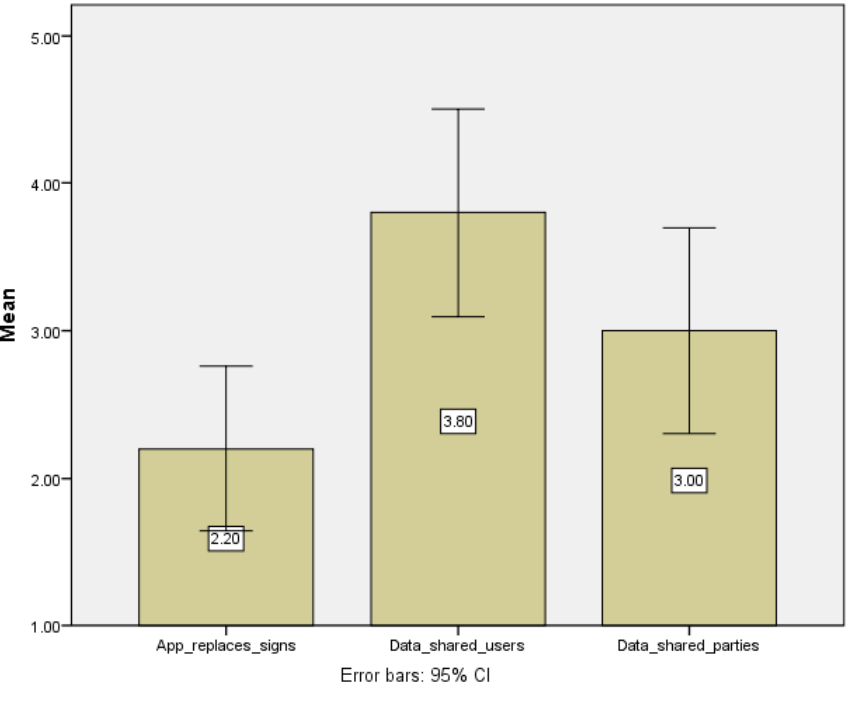
Figure 6 . Descriptive statistics of the data-sharing related questions . Figure 6. Descriptive statistics of the data-sharing related questions.